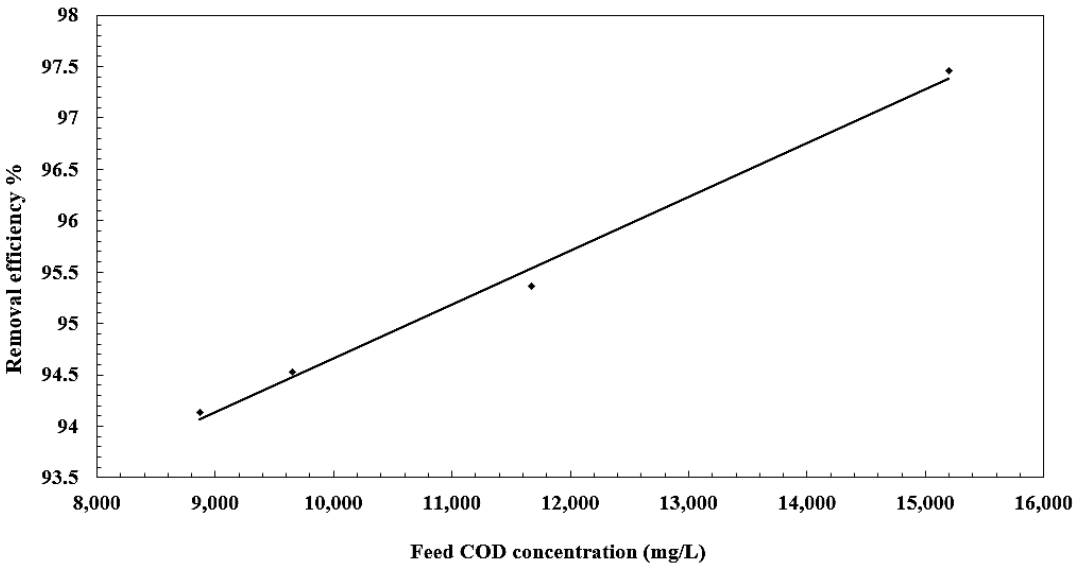
ff ect of feed concentration on removal e ffi ciency. Figure 12. Effect of feed concentration on removal efficiency. Figure 12. E